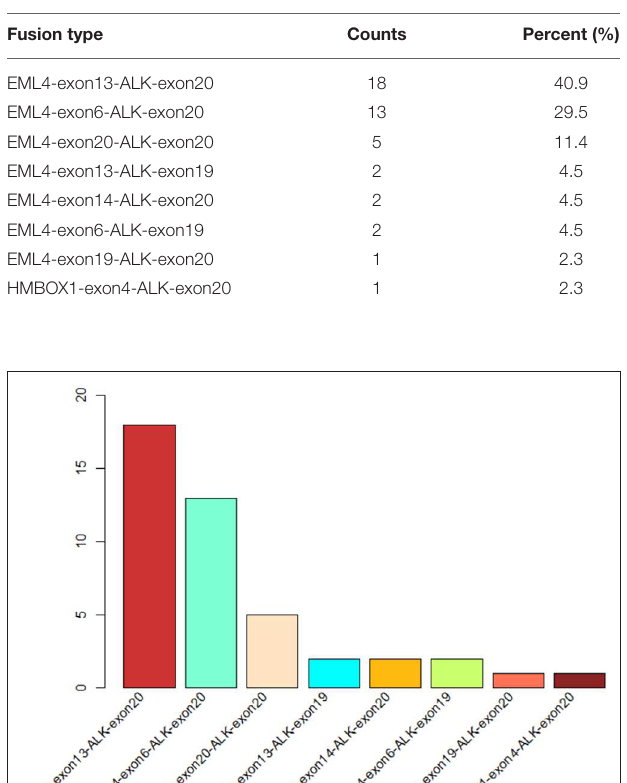
TABLE 1 | Fusion patterns of ALK.